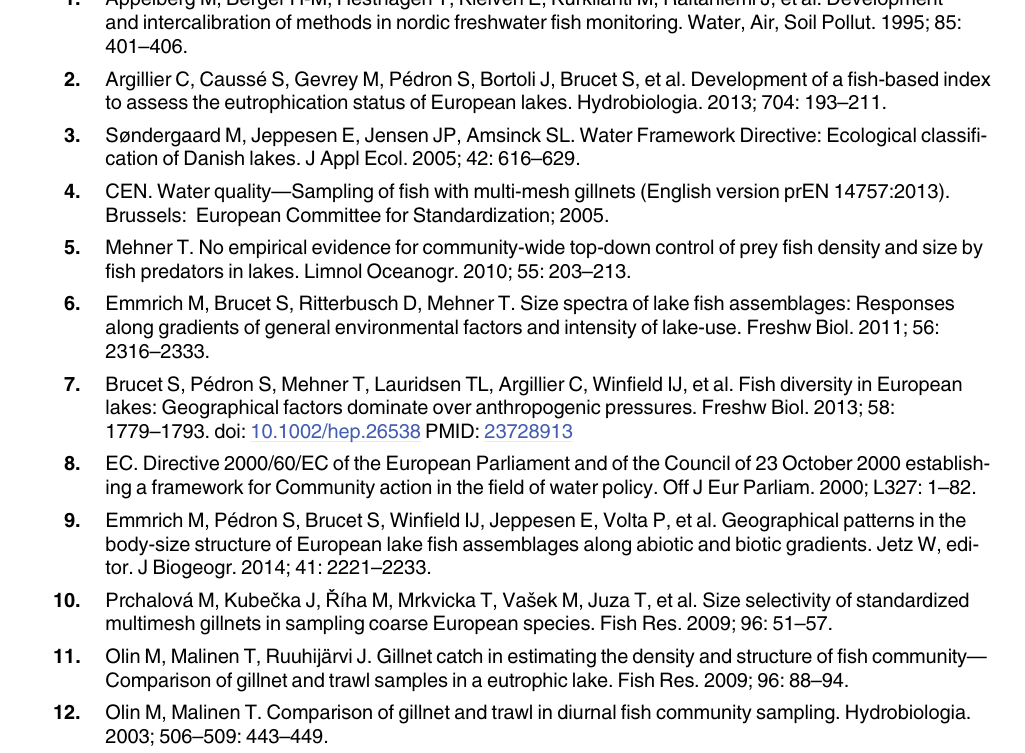
S1 Table. Single mesh gillnet catch and effort summary. Summary of gillnet effort (number of nets), sampled area and number of fish recorded in each SMG mesh size, Ř ímov Reservoir,